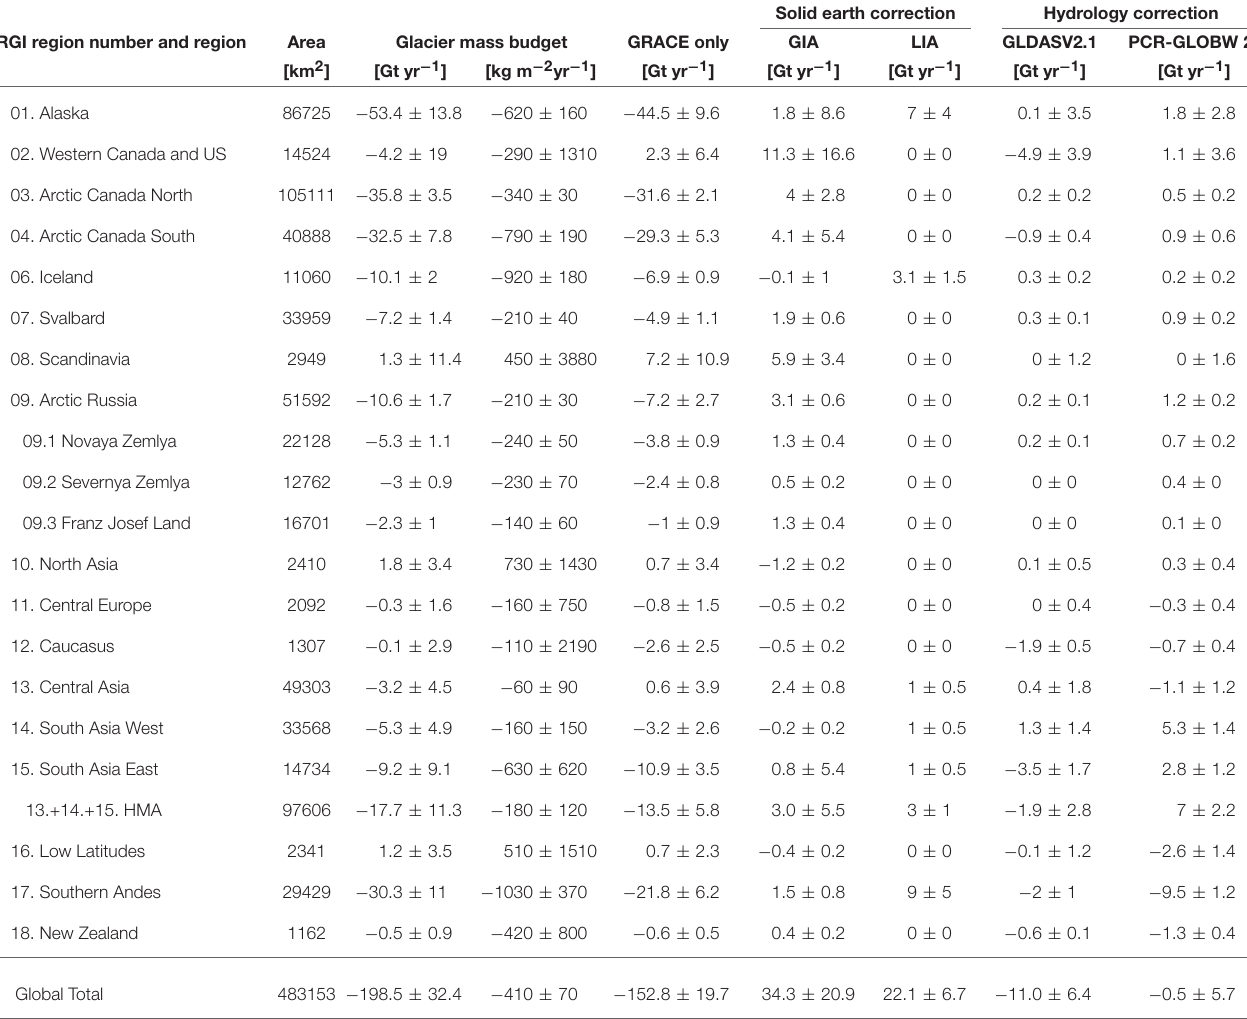
TABLE 1 | Average GRACE mass trends and corrections for April 2002-August 2016.